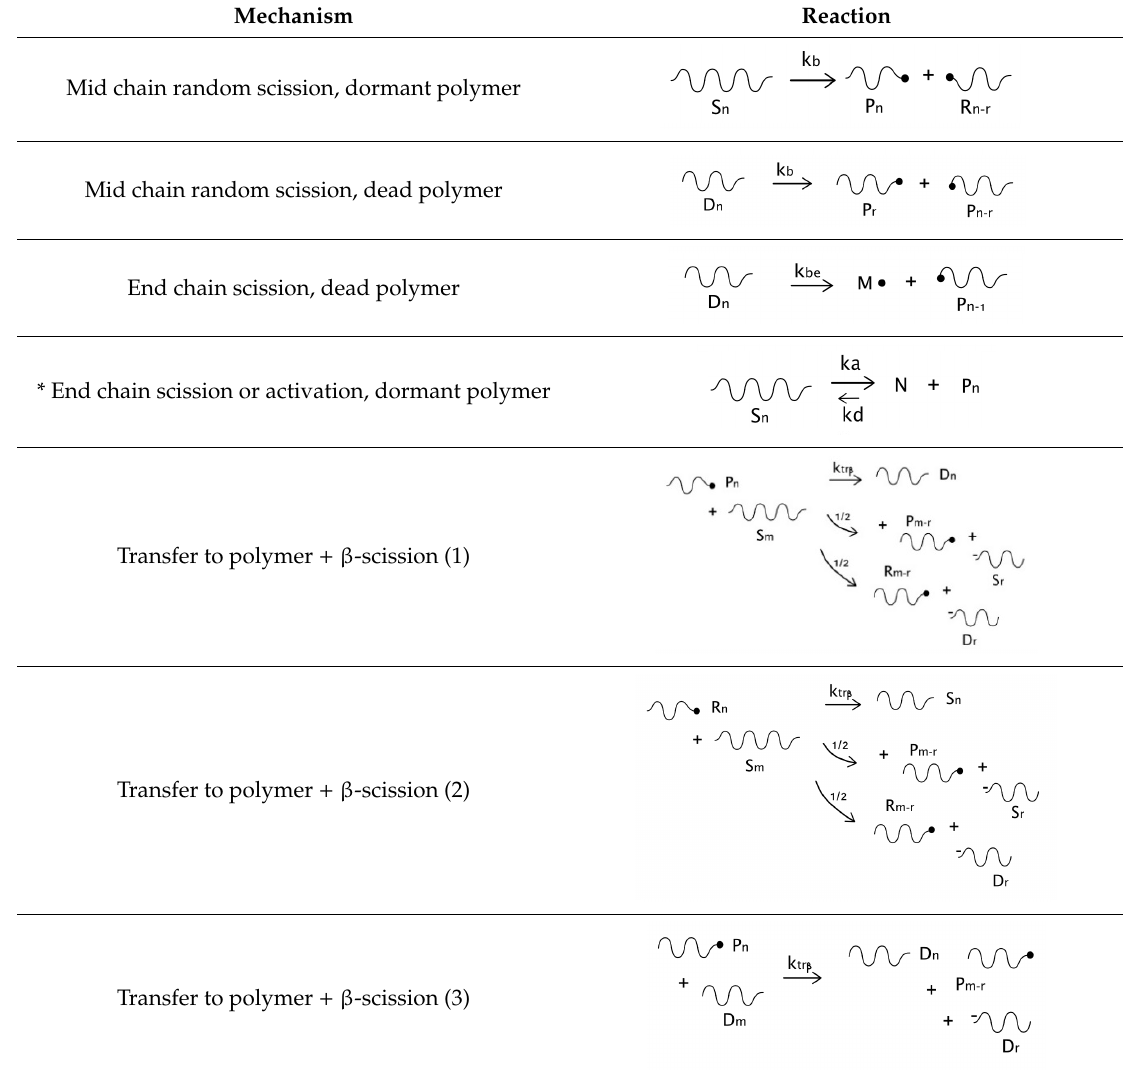
Table 3. Polystyrene depolymerization kinetic mechanism including the presence of nitroxide-end polystyrene.